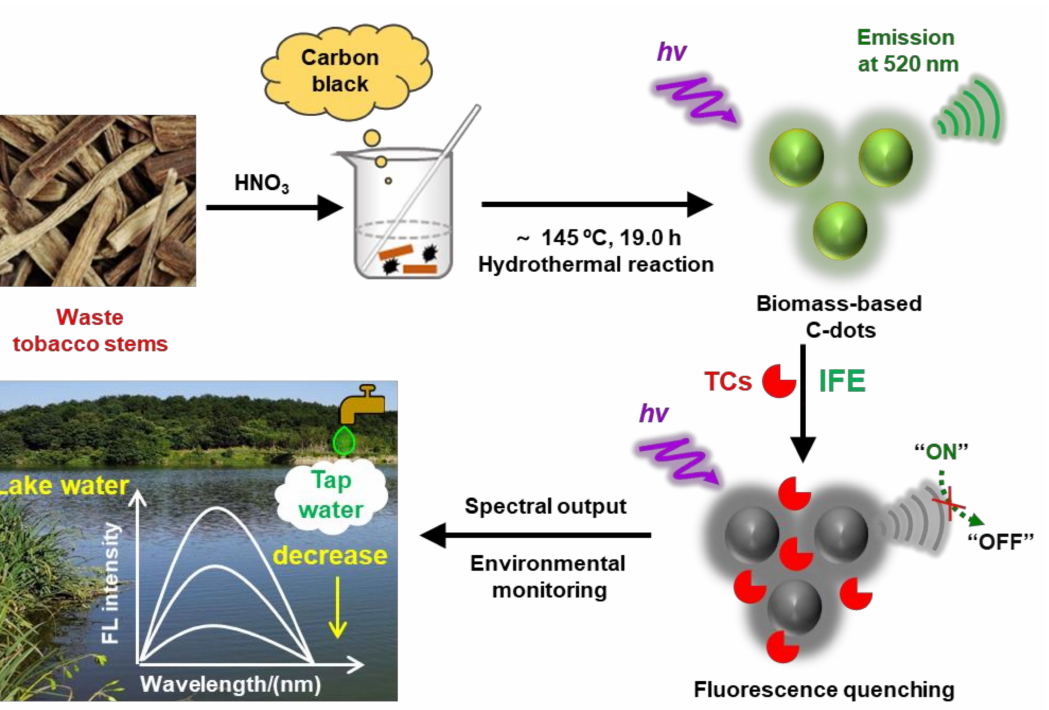
Figure 1. Illustration of the synthesis procedure for waste tobacco stems biomass − based C − dots and their fluorescence response mechanism toward TC